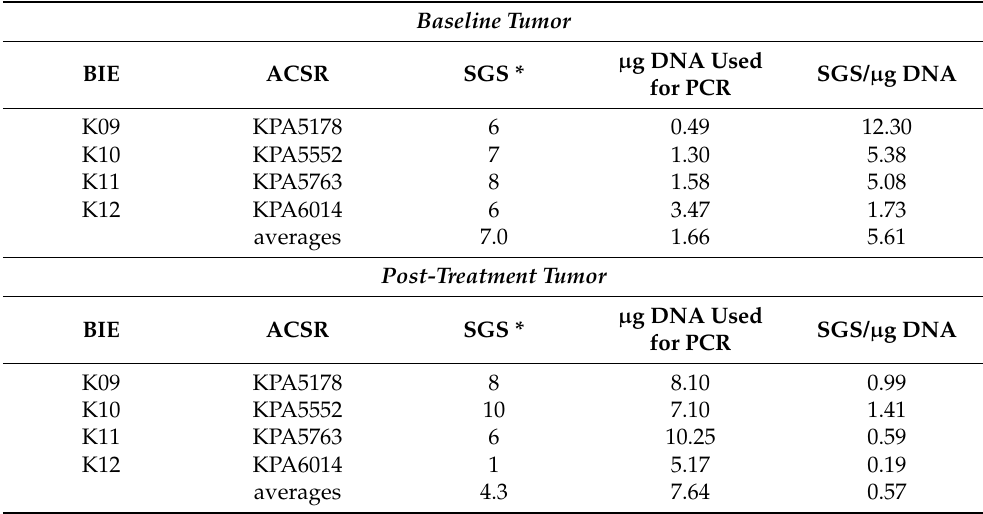
Table 4. Calculated number of env-nef sequences per microgram tumor